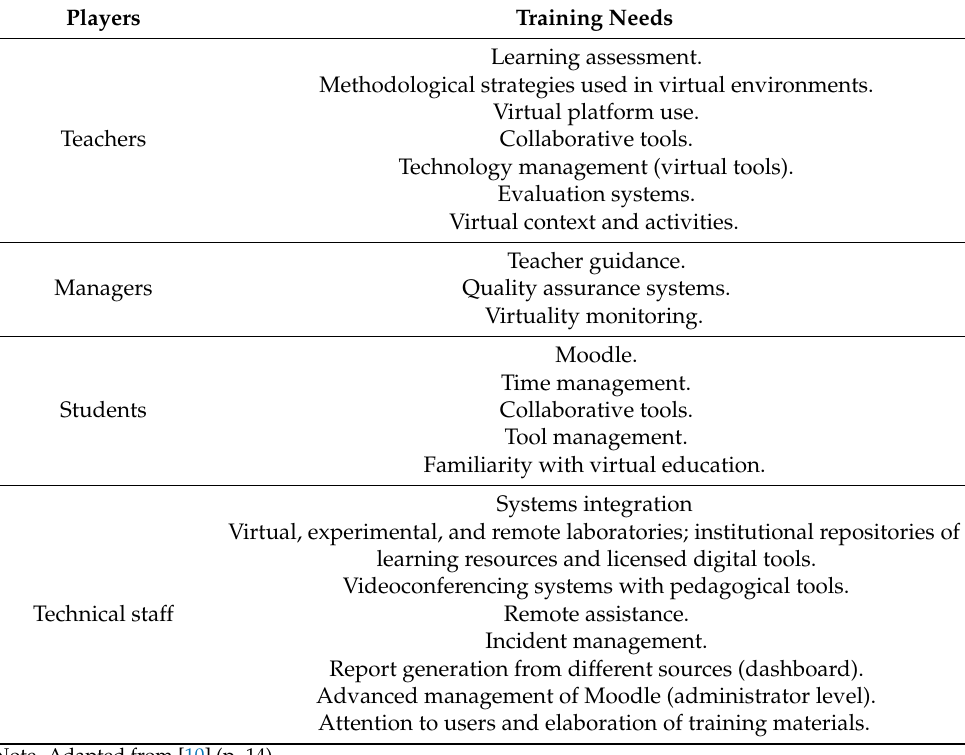
Table 2. Identified needs.